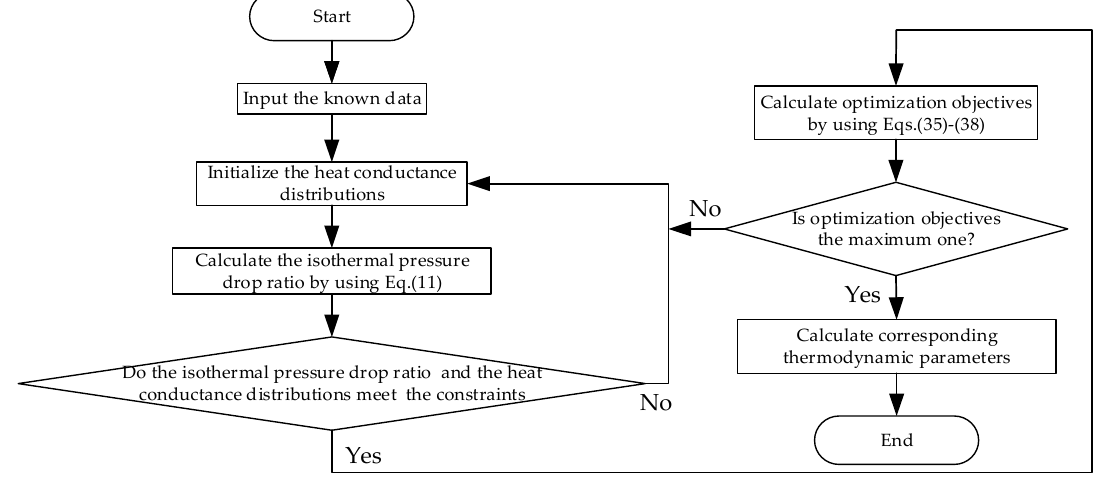
Figure 9. Optimization flowchart for single objective.